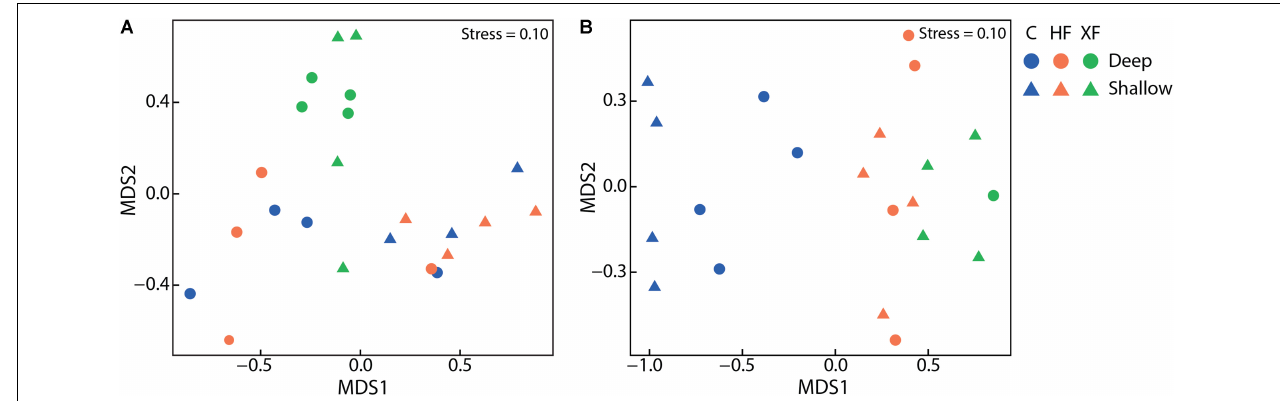
FIGURE 4 | Non-metric multidimensional scaling plots of (A) total microbial communities as assessed from sequences of the 16S rRNA gene and (B) potentially active communities, as assessed with 16S rRNA, using Bray–Curtis similarities. Total microbial communities varied as a function of treatment and depth and potentially active communities varied solely as a function of treatment.